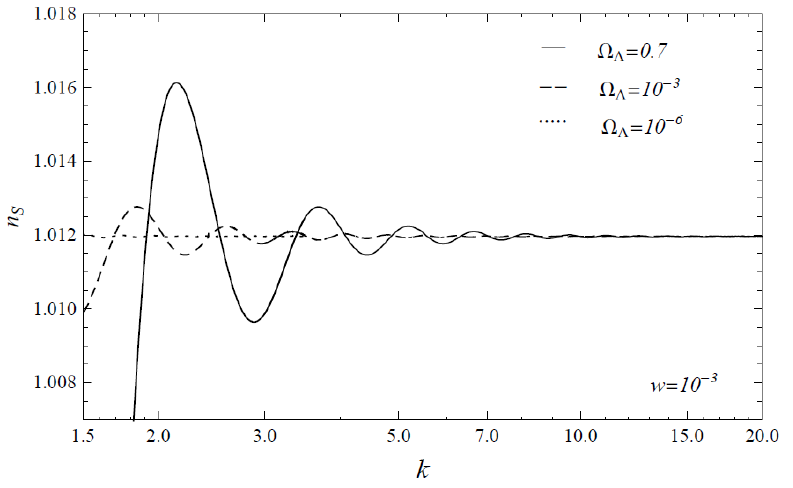
Figure 5. Numerical results for n S ( k ) in the presence of a cosmological constant. The solid line shows the result obtained using Ω Λ = 0.7; the dashed line, that for Ω Λ = 10 − 3 ; and the dotted line, that for Ω Λ = 10 6 . The oscillations become smaller for smaller Ω Λ , indicating that they arise because of the − presence of the cosmological